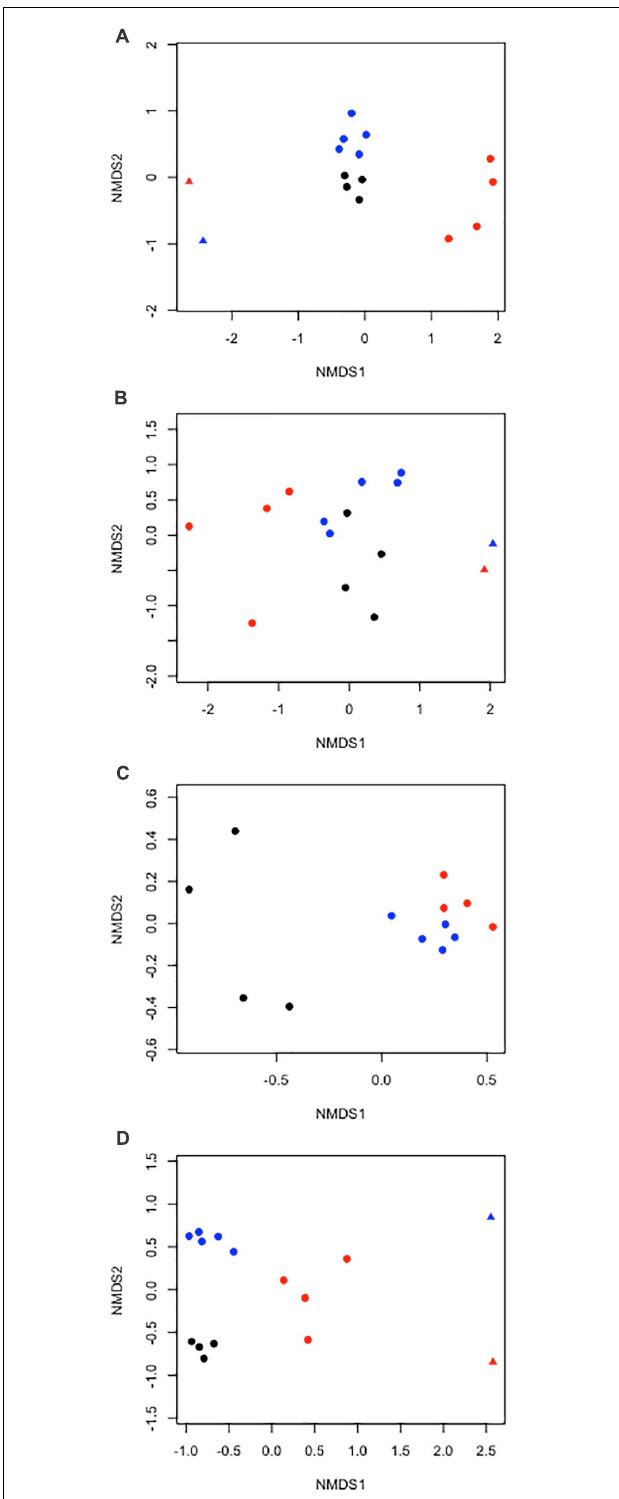
FIGURE 7 | Two-dimensional non-metric multidimensional scaling ordination plots of community composition similarity for echinoderm (A) density and (B) biomass (fresh wet weight), (C) poriferan density, and (D) cnidarian density on the abyssal plain (circles) and seamounts (triangles) in the APEIs (1 = black, 4 = blue, 7 = red